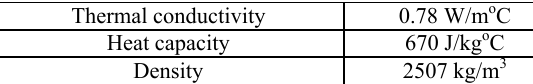
Table 1.The properties of the glass spheres [36] Thermal